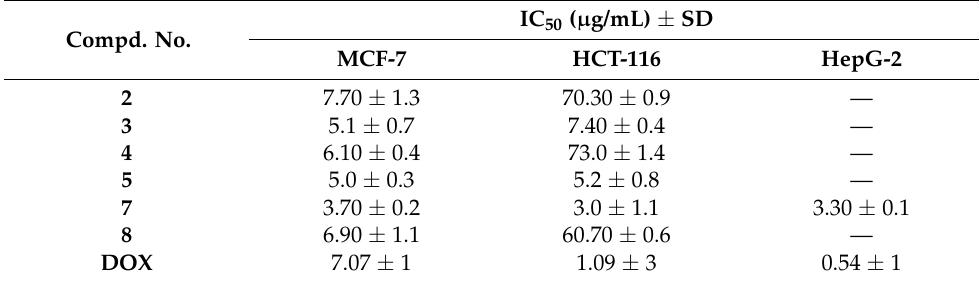
Table 1. IC 50 values of the GA-based peptides against different cancer cell lines. Compd.